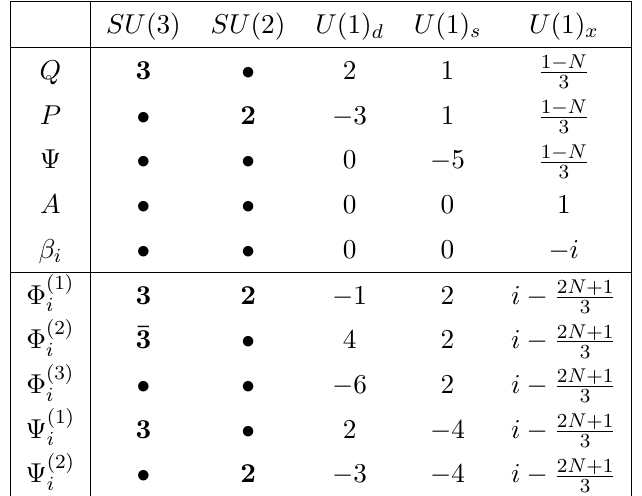
and theory T 4d A B